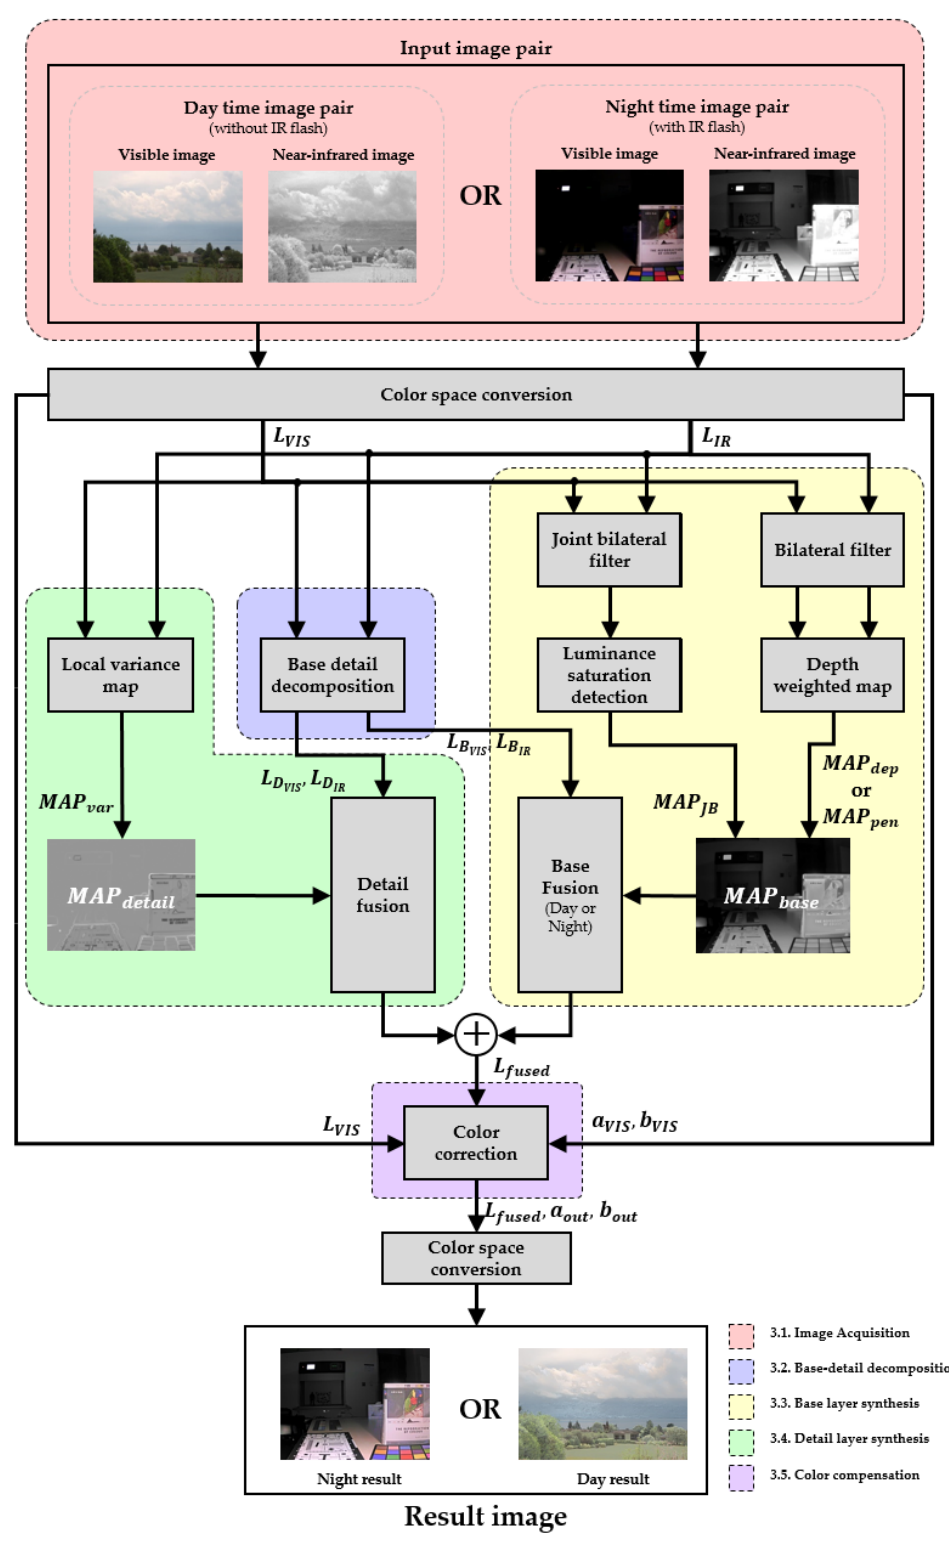
Figure 2. Flowchart of proposed